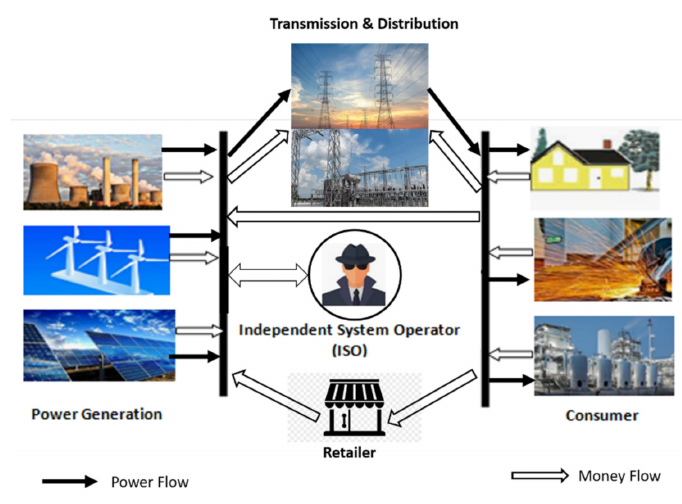
Figure 1. The grid with RES under deregulated